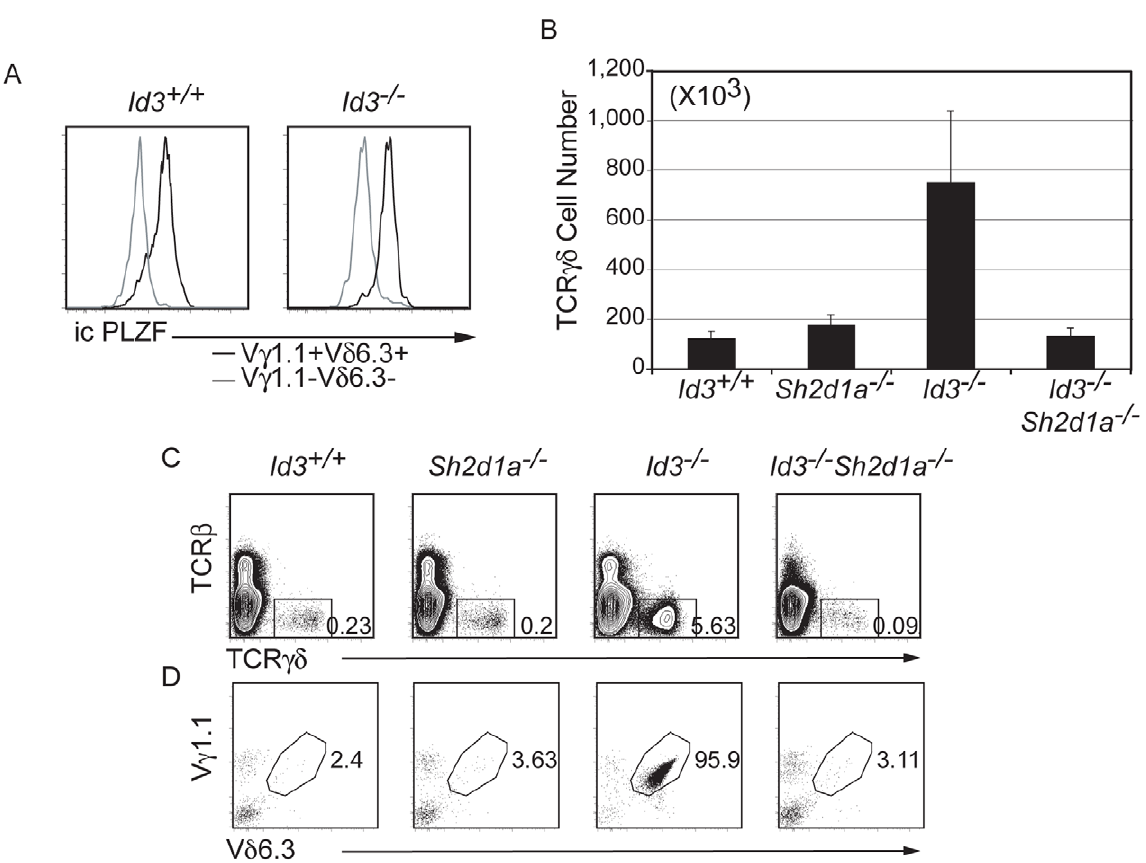
Figure 6. Id3 2 / 2 V c 1.1 + V d 6.3 + T cells express PLZF and require SAP. A) Intracellular FACS analysis for expression of PLZF in Id3 + / + and Id3 2 / 2 thymic V c 1.1 + V d 6.3 + (black) and V c 1.1 2 V d 6.3 2 (grey) cd T cells. (B) Number of TCR cd + cells in the thymus of mice of the indicated genotype. Sh2d1a 2 / 2 mice fail to express the gene encoding SAP. Average + / 2 standard deviation derived from 6 mice. Id3 2 / 2 mice have more TCR cd + cells than any of the other genotypes (p , 0.05) (C) FACS analysis for TCR b and TCR c expression on total thymocytes from mice of the indicated genotype. The frequency of TCR cd + cells is shown. (D) Analysis of TCR cd + cells for expression of V c 1.1 and V d 6.3. The frequency of V c 1.1 + V d 6.3 + cells among TCR cd + cells is